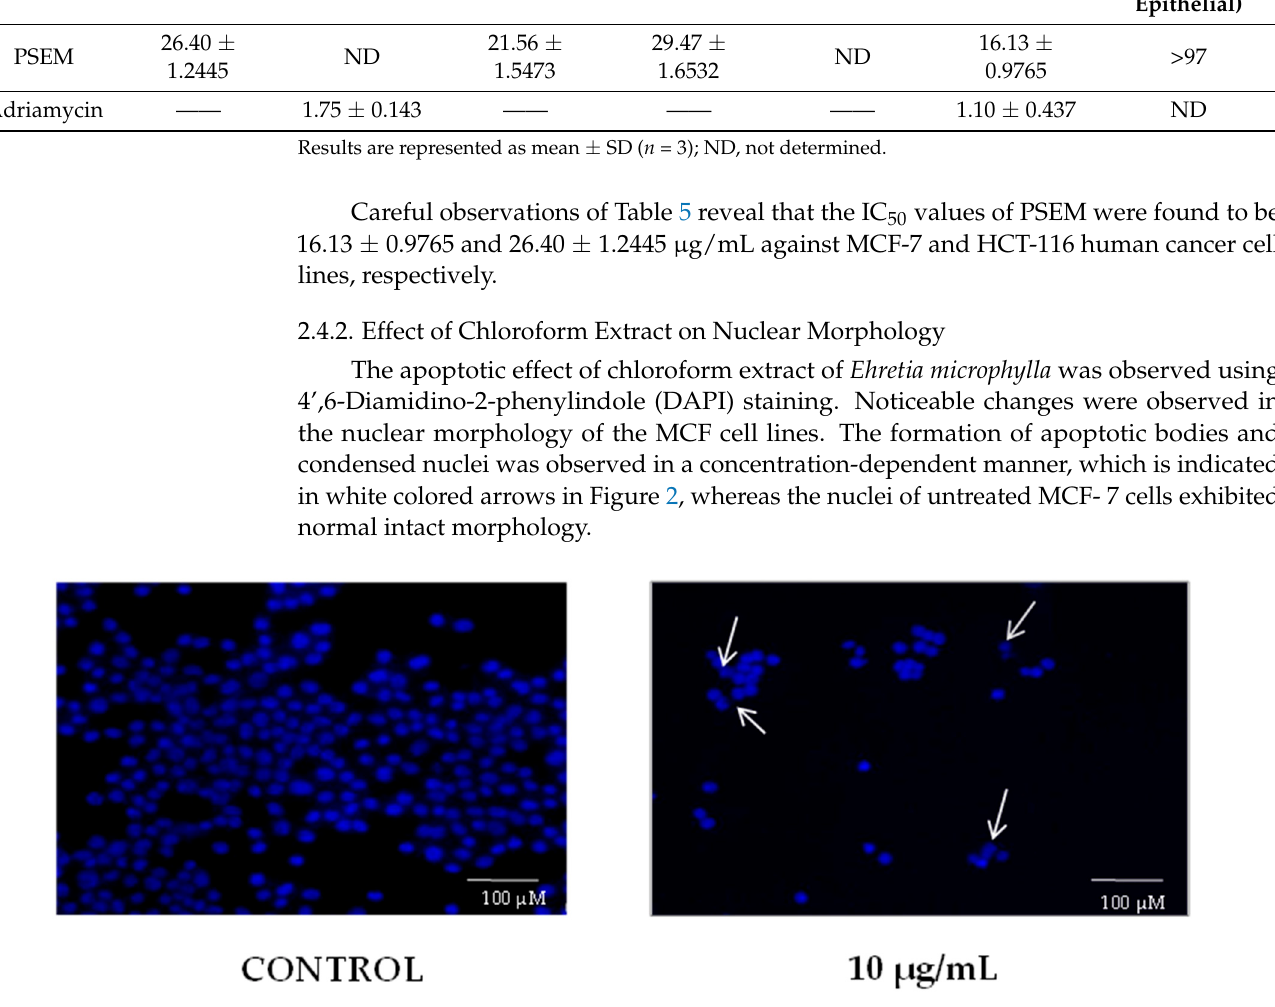
Figure 2. DAPI staining in MCF-7 cell lines. Variation in nuclear morphology induced with PSEM in a concentration-dependent manner, observed under fluorescence microscope. PSEM induced the formation of apoptotic bodies, as shown by arrows. The photographs depicted here are magnified at × 20, and scale bars, 100 µm. 3. Discussions Cancer is one of the foremost threats to mankind worldwide after cardiovascular disorders. Numerous chemotherapeutic agents are clinically available and are approved by the FDA for the mitigation of cancer. Cancer therapy in the form of surgery or radio- therapy is effective when the disease is detected early, but many cancers are still diag- nosed after the cells from a primary tumor have metastasized to other parts of the body, and chemotherapy is the main form of treatment at this point [30]. Chemotherapy in- volves delivering drugs systemically so that they can reach and kill tumor cells, but most of these drugs have severe side effects in patients and must therefore be used at low doses. Researchers claim that developing new drugs that are more selective for cancer cells and have fewer side effects is a major challenge [31]. Integrative medicine, which combines traditional western medicine with alternative or complementary treatments such as herbal medicine, acupuncture, massages, bio- feedback, yoga, and stress management techniques, is being used to supplement ortho- dox medicines and treatment approaches in the management of cancer patients. Despite the availability of chemotherapeutic agents, the scientific community is still facing chal- lenges to seek out novel entities for the treatment and management of different types of cancer because of the agents’ harmful side effects. Researchers are currently inclined toward the search for natural products because of the presence of abundant therapeutically accepted phytomolecules such as flavonoids, tannins, amino acids, alkaloids, sugars, tannins and polyphenolic compounds, despite